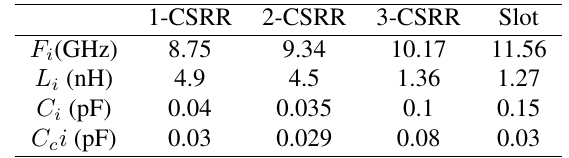
Table 2: Element parameters of the structures shown in Fig.